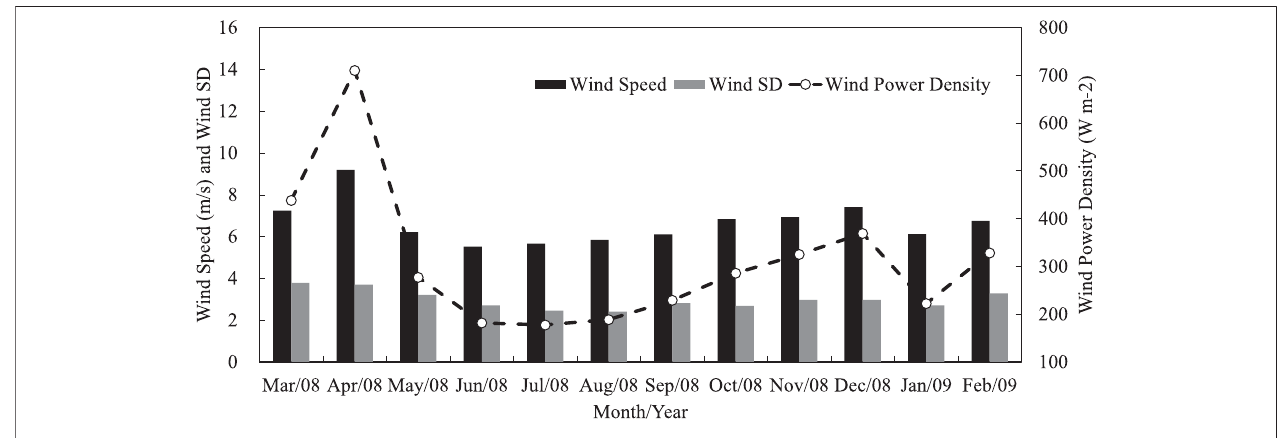
FIGURE 1 | The observed mean and standard deviation (SD) of wind speed (unit: m s − 1 ), wind power density (unit: W m − 2 ) in each month from March 2008 to February 2009 (The x -axis represents the month of a speci fi c year; the y -axis on the left is the mean and standard deviation of wind speed, the y -axis on the right represents the wind power